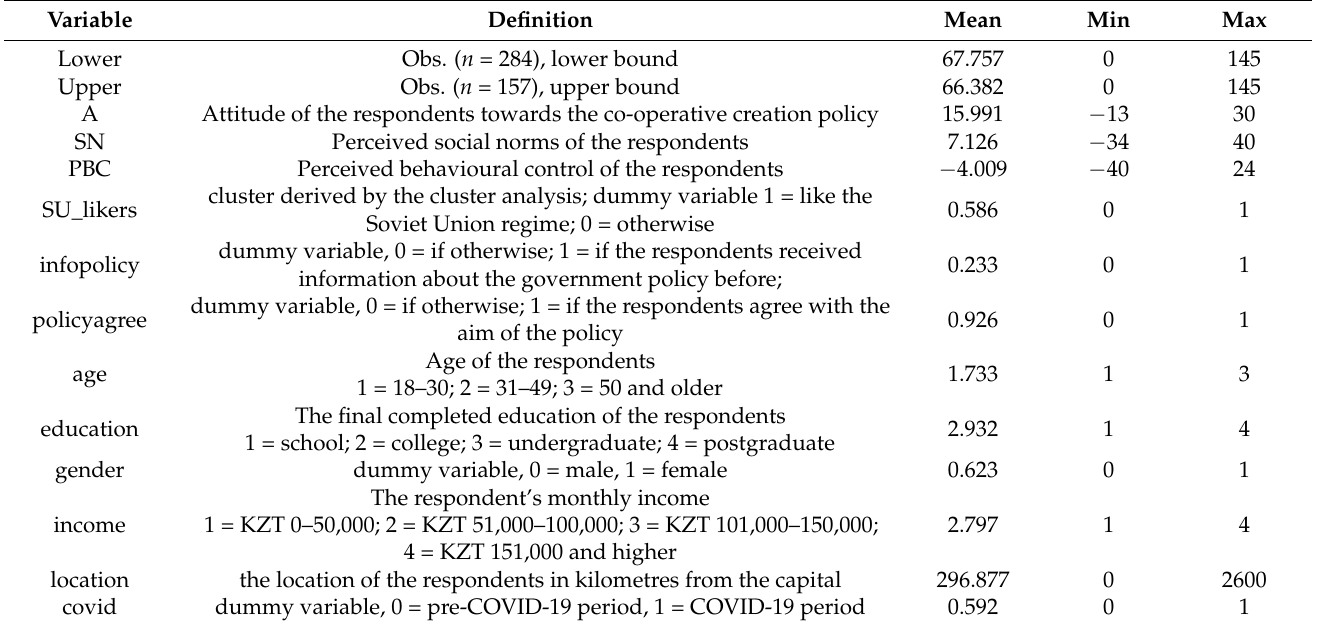
Table 2. Variable definitions and statistical descriptions.